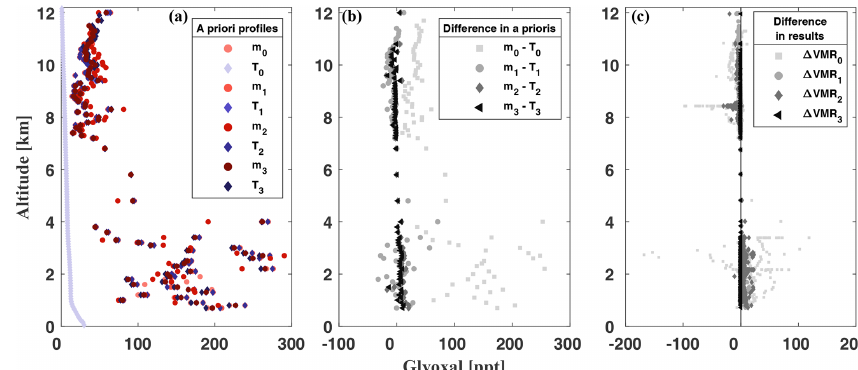
Figure 1. Iterations of different a priori glyoxal profiles in α -factor calculations, shown here for the HALO flight on 15 May 2018 (CoMet mission). Starting a priori profiles are a mean glyoxal profile inferred from previous mini-DOAS measurements in polluted continental air ( m 0 ) and an averaged glyoxal profile simulated by the MAGRITTE model ( T 0 ) for a TROPOMI overpass over Europe at 13:30UTC on 15 May 2018 (Lerot et al., 2021). These a priori profiles are used for the first iteration in the α -factor calculations. The resulting profiles are then used for the following i iterations to obtain the profiles m i and T i , respectively (a) . The differences m i − T i in the a priori profiles after each iteration step are shown in panel (b) . The differences in the resulting mixing ratios from each iteration step (based on the respective α -factor simulation) are shown in panel (c)